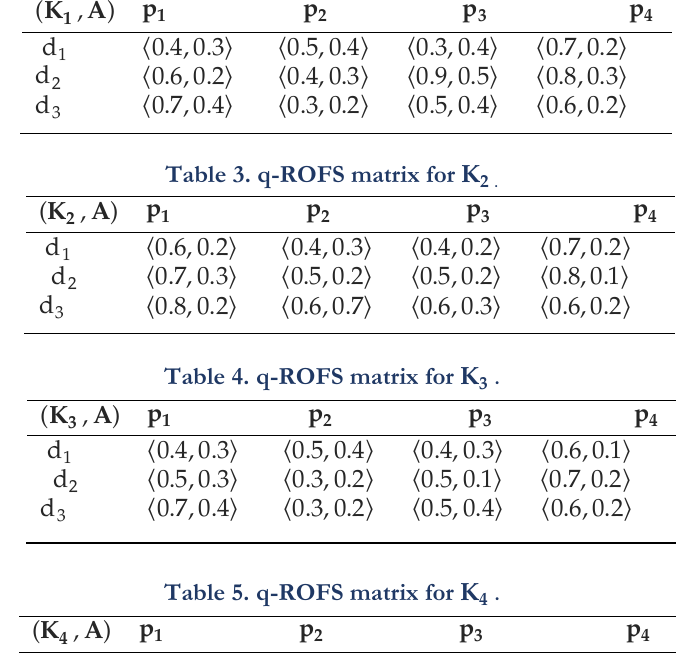
Table 2. q-ROFS matrix for 𝐊